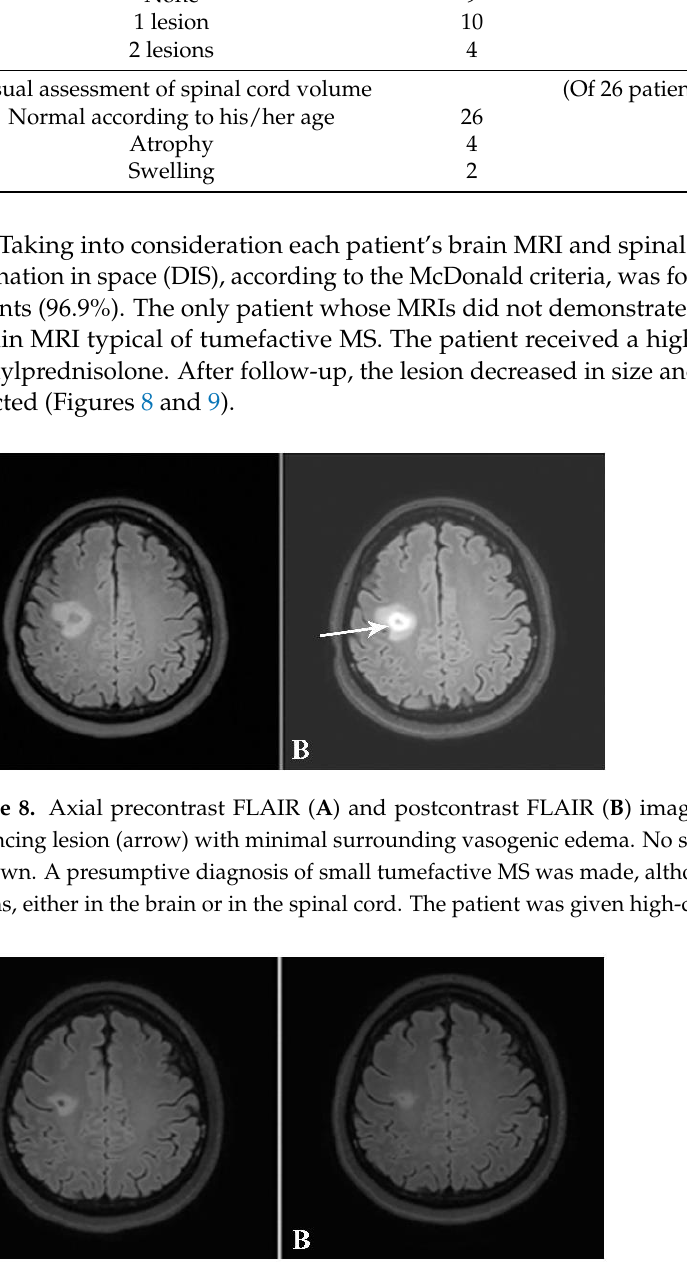
Figure 9. Follow-up axial postcontrast FLAIR images of the same patient after treatment with ster- oids at 2 and 6 months ( A and B , respectively), showing decreased size of the lesion without residual enhancement.